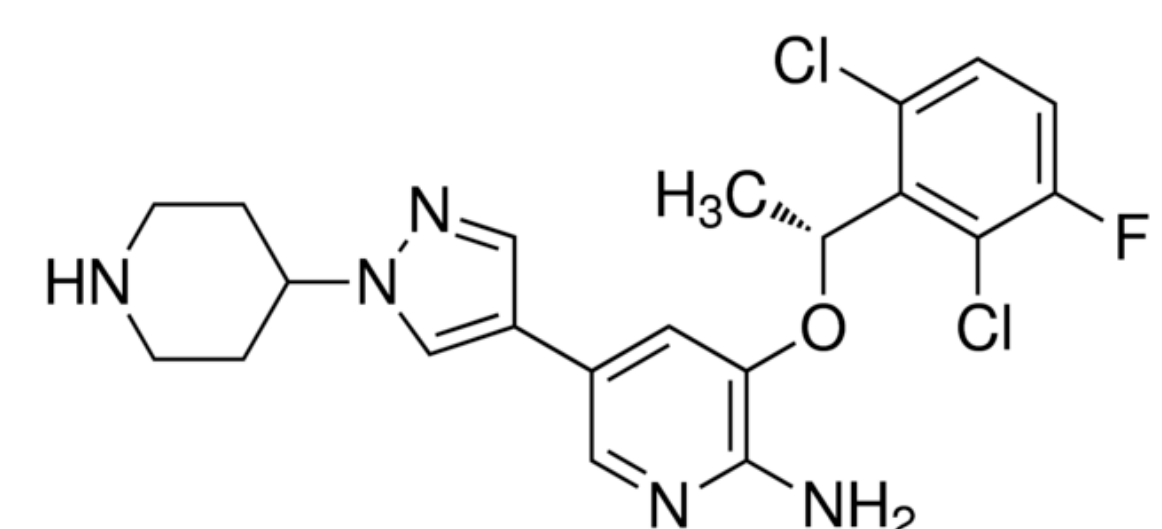
Figure 8. Crizotinib—first-generation Anaplastic Lymphoma Kinase tyrosine kinase inhibitor (ALK TKI).